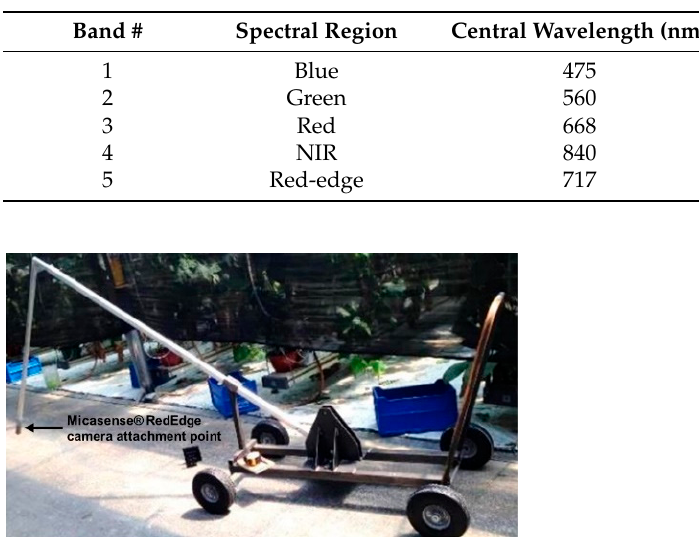
Table 1. Spectral information of each band from the MicaSense ® RedEdge camera.